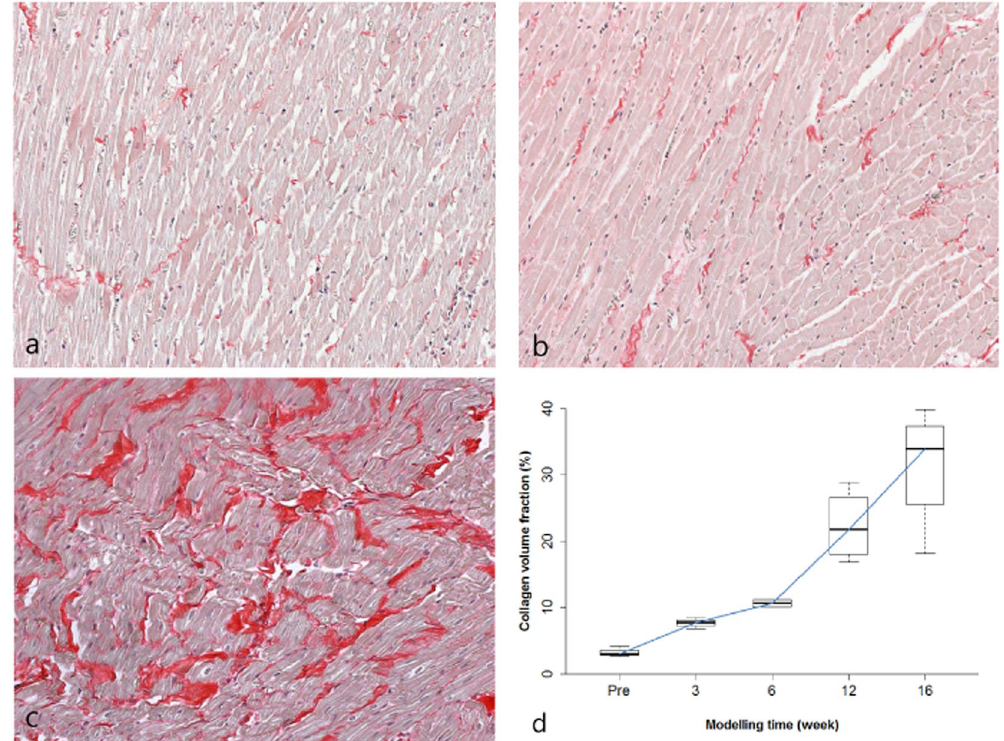
Figure 4. Histological images of extracellular collagen deposition in the left ventricle (LV) myocardium. ( a ) Minimal collagen fibres are visible in the interstitium of a baseline subject (measured collagen volume fraction [CVF] = 3.04%). ( b ) No significant increase in collagen fibres was observed in a 3-week model (CVF = 4.28%). ( c ) Abundant collagen deposition is visible in a 16-week model (CVF = 25.00%). Picrosirius red staining; original magnification, × 200 ( d ) Myocardial fibrosis according to the modelling